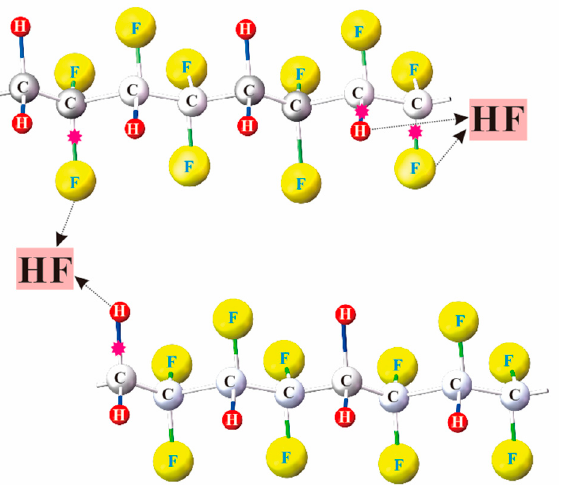
Figure 4. The all-trans molecular conformation of P(VDF–TrFE). The black dotted line indicated that